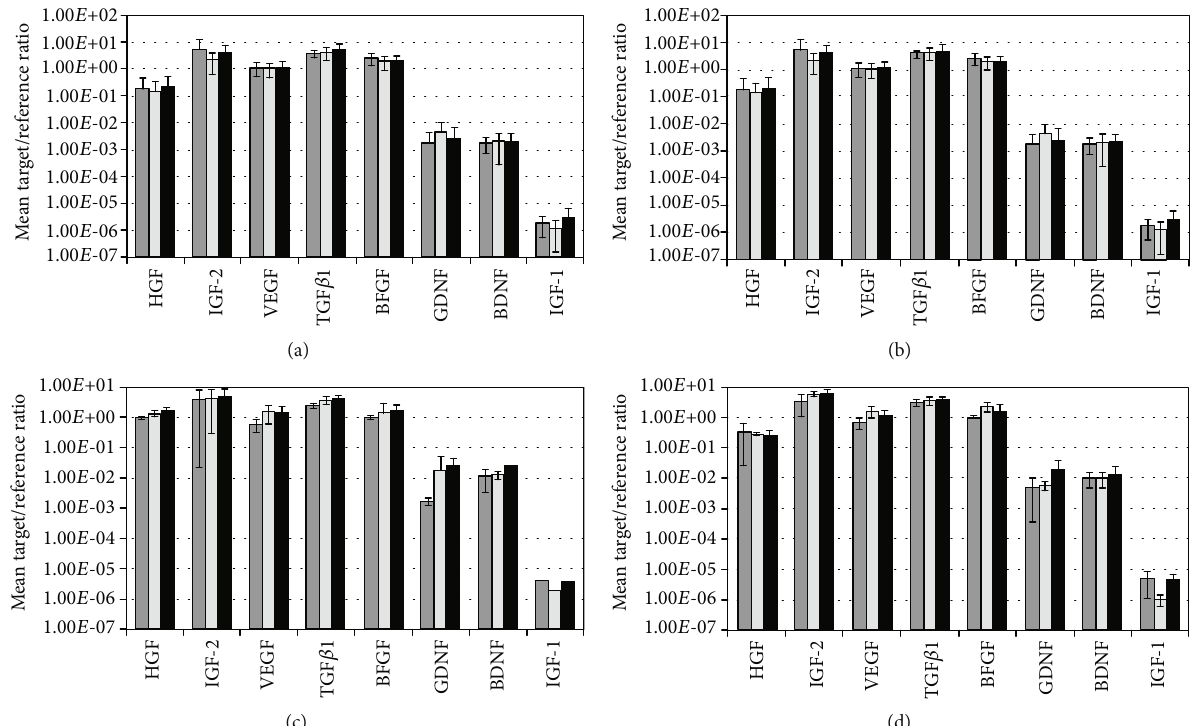
Figure 5: The expression of cytokines in di ff erent MSCs in di ff erent GMP-compliant media. The bmMSCs (a), ADSCs (b), fpMSCs (c), and mpMSCs (d) were expanded ex vivo in 3 di ff erent GMP-compliant media ( serum = dark grey bars , serum + PLL = lightgrey bars , plasma + PLL = black bars ). Transcripts encoding HGF, IGF-2, VEFG, TGF- β 1, BFGF, GDNF, BDNF, and IGF-1 were enumerated by qRT-PCR. The graphics show the mean target gene to reference gene ratios from n ≥ 3 individual MSC expansions and